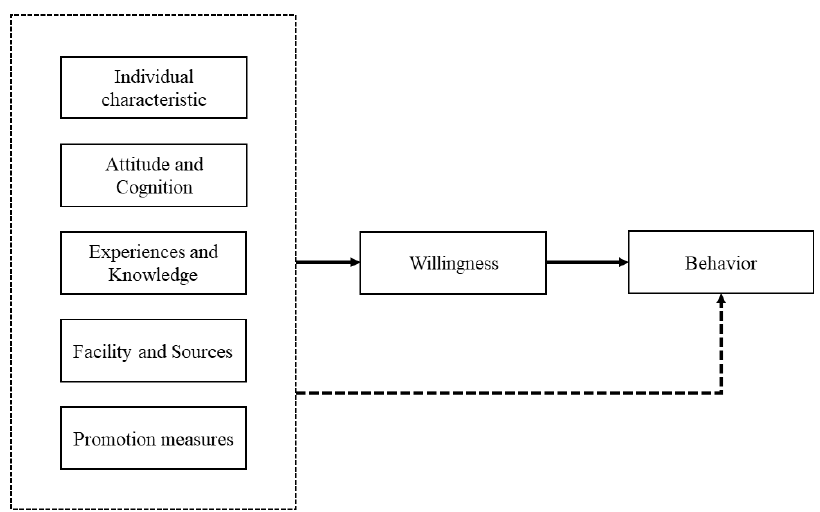
Figure 1. Mechanism model of the effect of factors influencing the willingness and behavior of using recycled water.